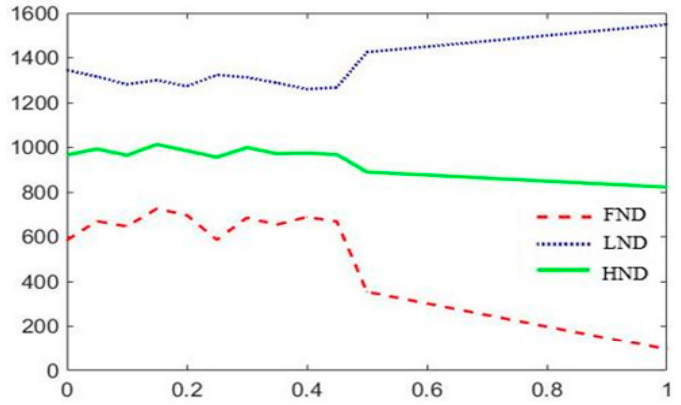
Figure 11. Network lifetime schematic diagram of the trend of w 3.